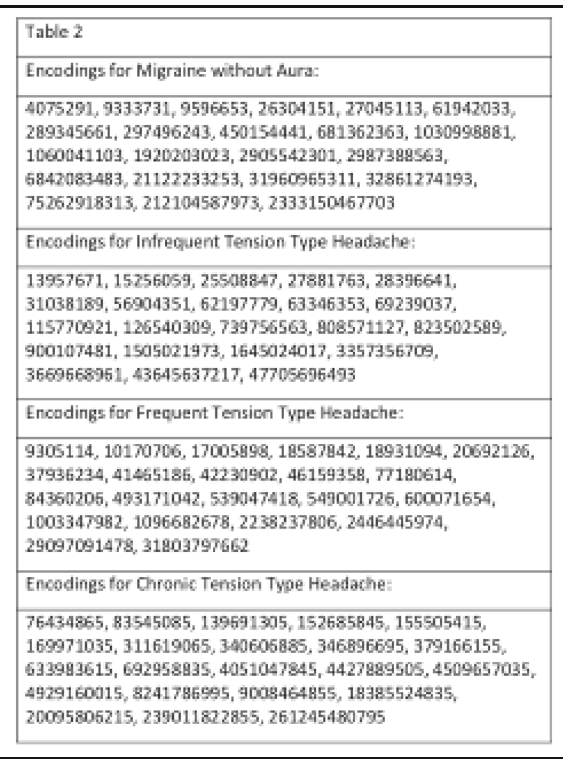
Table 2 (abstract P199). See text for